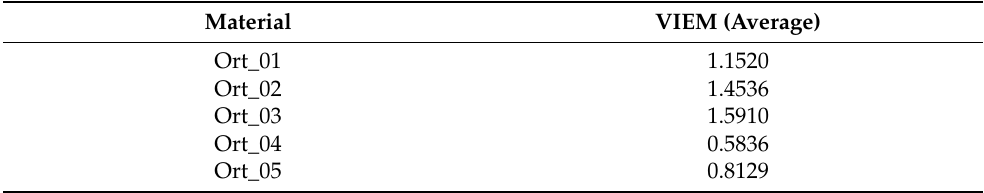
Table 9. Normalized tensile stress component ( σ xx / σ o xx ) within the orthotropic spherical inclusion due to uniform remote tensile loading ( σ o xx